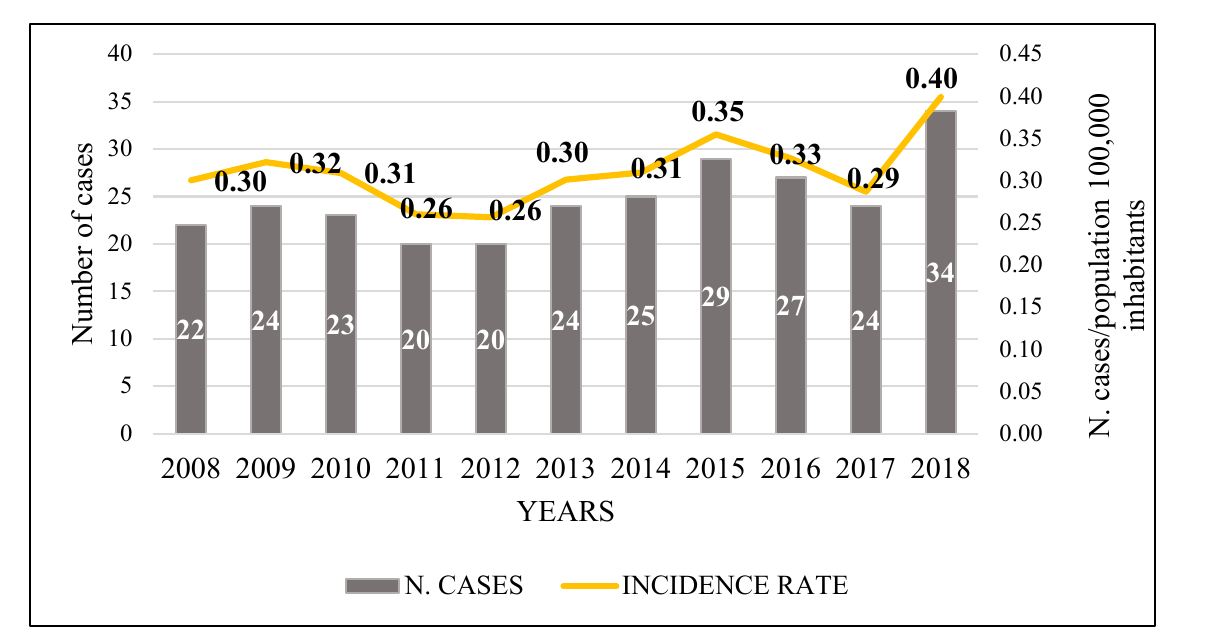
Figure 1. Distribution of the number of new cases of cryptococcosis per year and the incidence rate by state population per 100,000 inhabitants, 2008–2018, JBBUH, Pará, Brazil. logical condition, which had a mortality rate 47.1% higher in patients co-infected with HIV. Table 4. Clinical evolution of patients with cryptococcosis according to the present immunological condition, 2008–2018, JBBUH, Par á ,